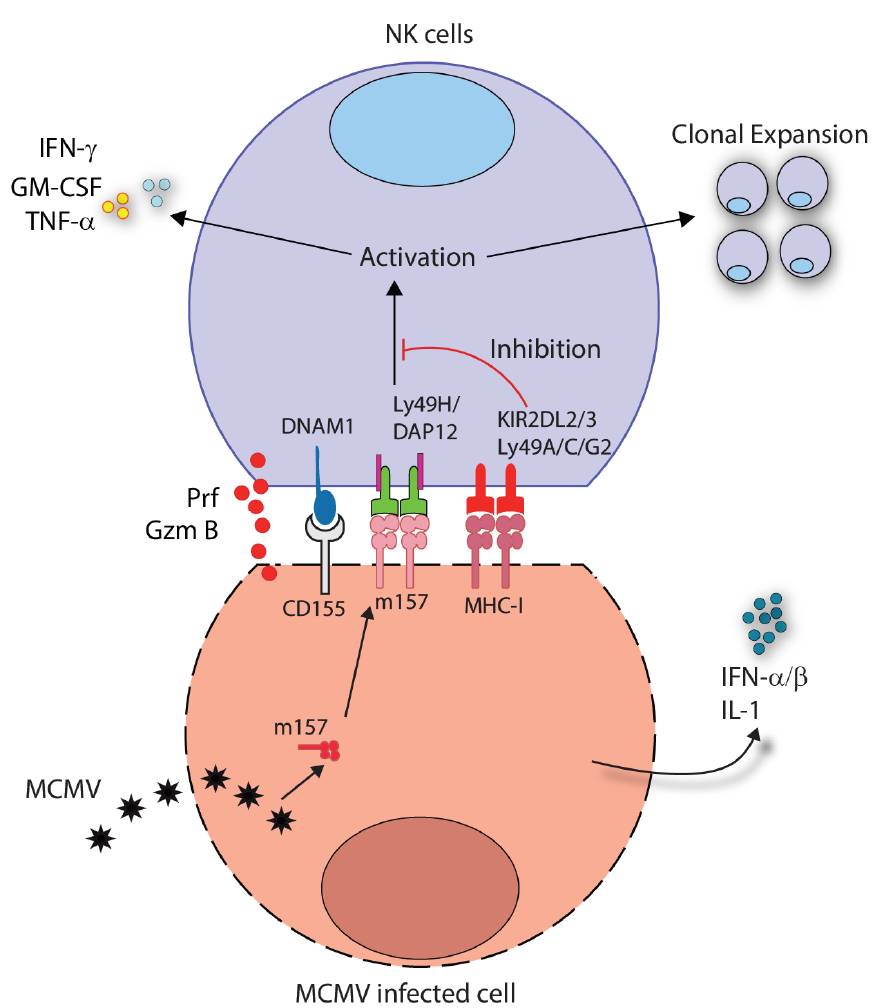
Figure 3. Germline-encoded Ly49H mediate viral antigen-specific recognition. During mouse cytomegalovirus (MCMV) infection, NK cells expressing the Ly49H receptor recognize MCMV- infected cells via the MCMV-derived glycoprotein m157. Stimulation of the Ly49H leads to the activation of the DAP12-mediated signaling pathway, driving NK cell degranulation and secretion of perforins and granzymes. DNAX accessory molecule-1 (DNAM-1) and pro-inflammatory cytokines (IFN- α / β and IL-1) partially drive the clonal-like expansion of NK cells. Inhibitory KIR2DL2/3 in humans and Ly49A/C/G2 in mice can block the membrane proximal activation events upon the recognition of MHC class I.